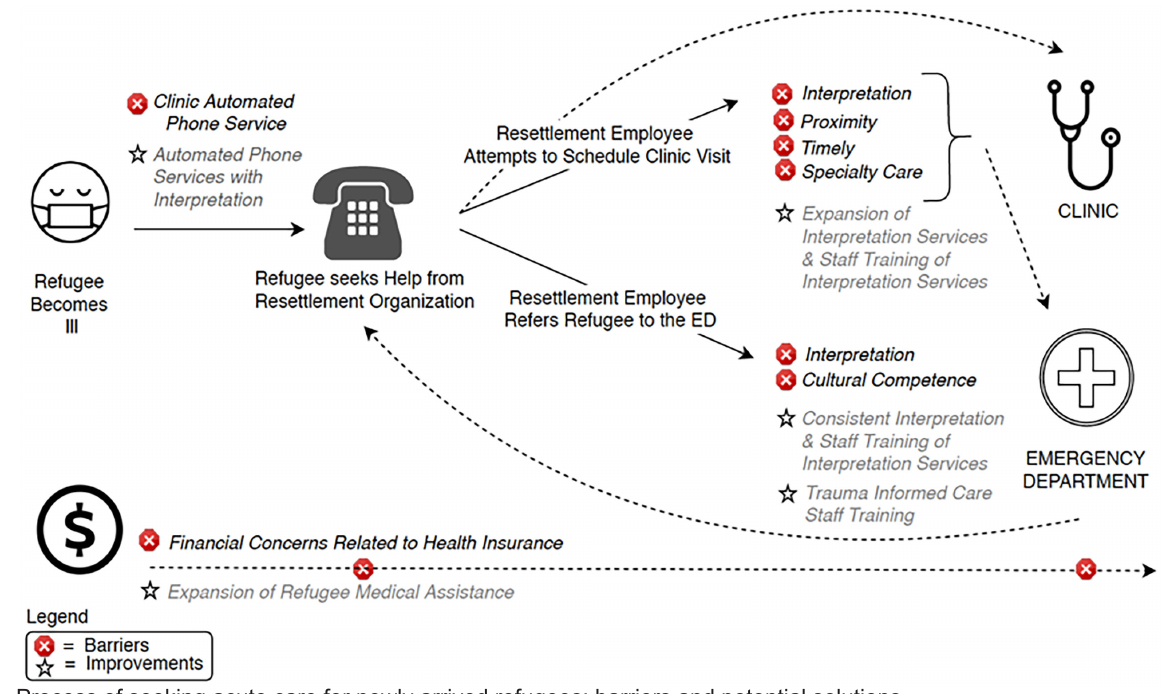
Figure 1. Process of seeking acute care for newly arrived refugees: barriers and potential